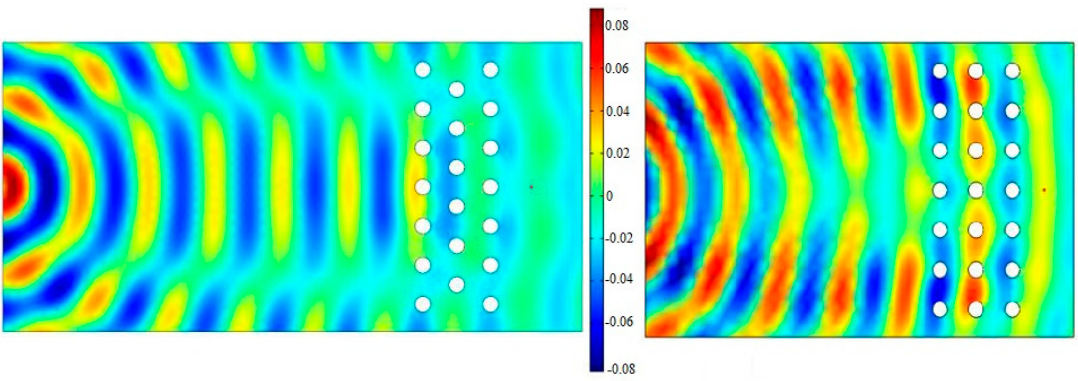
Figure 1. Sound pressure levels at 1.5 kHz for triangular and square lattice, modified from [39].